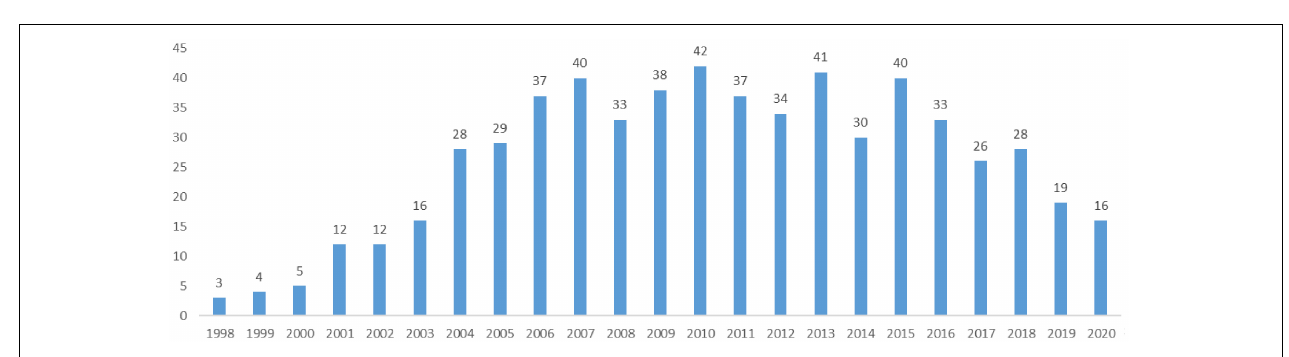
FIGURE 1 | Flow diagram of the bibliometric analysis performed with CiteSpace.